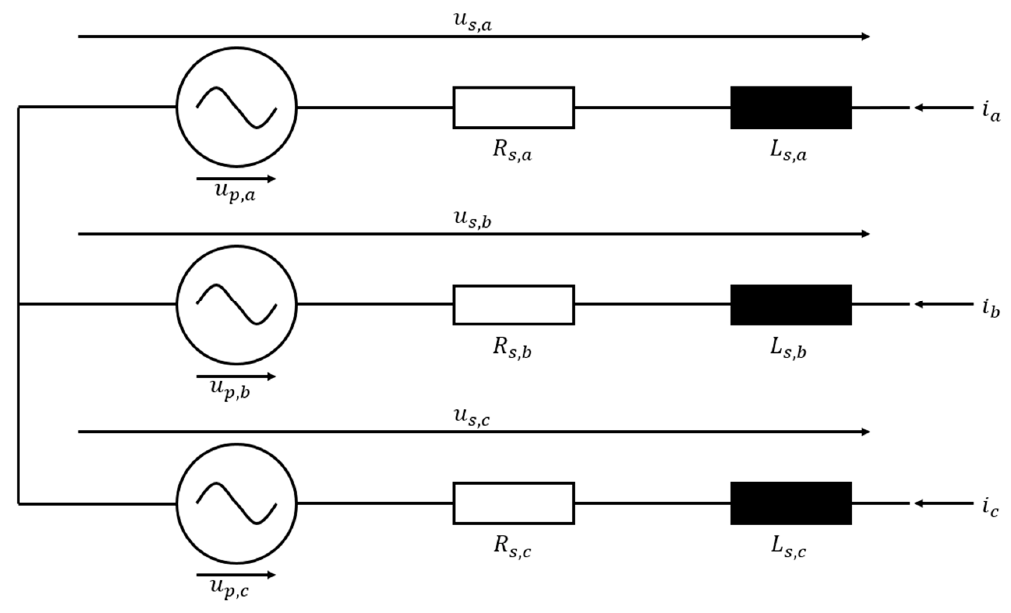
Figure 1. Simplified electrical equivalent circuit of a synchronous machine in star connection.